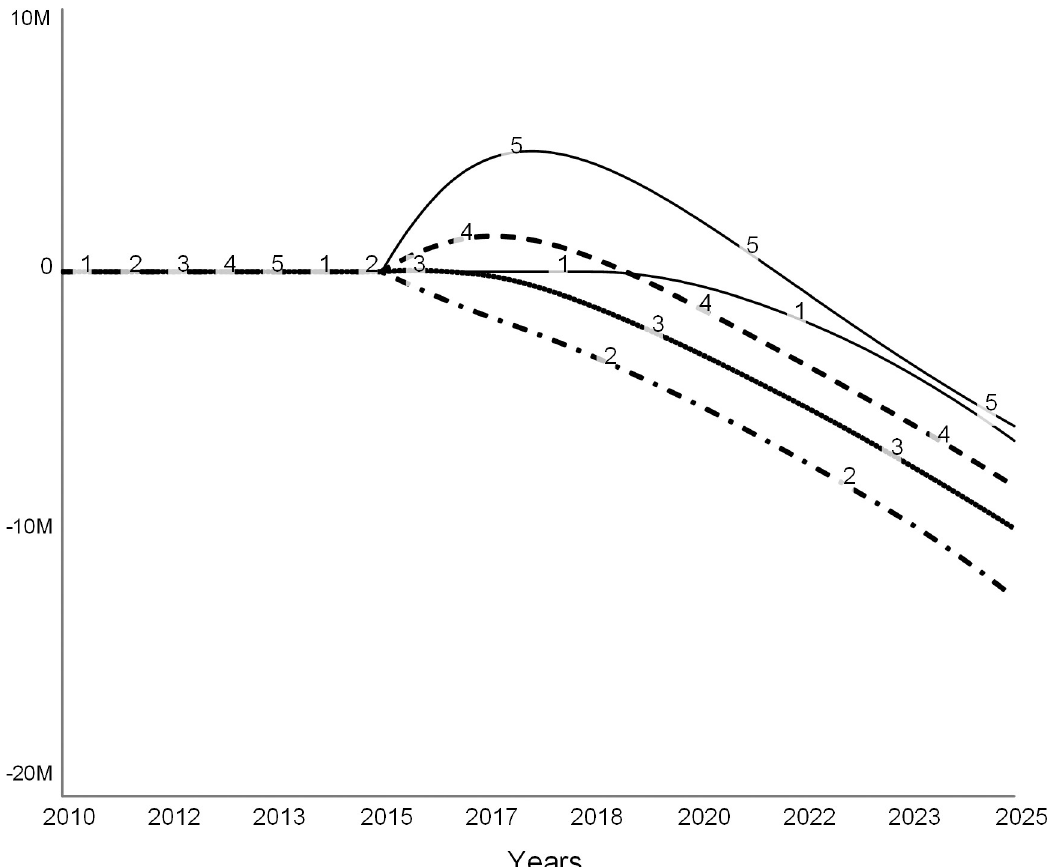
Fig 20. Net revenue. Curve 1: base run. Curve 2: 0% increase in enrollments. Curve 3: 5% increase in enrollments. Curve 4: 10% increase in enrollments. Curve 5: 20% increase in enrollments.